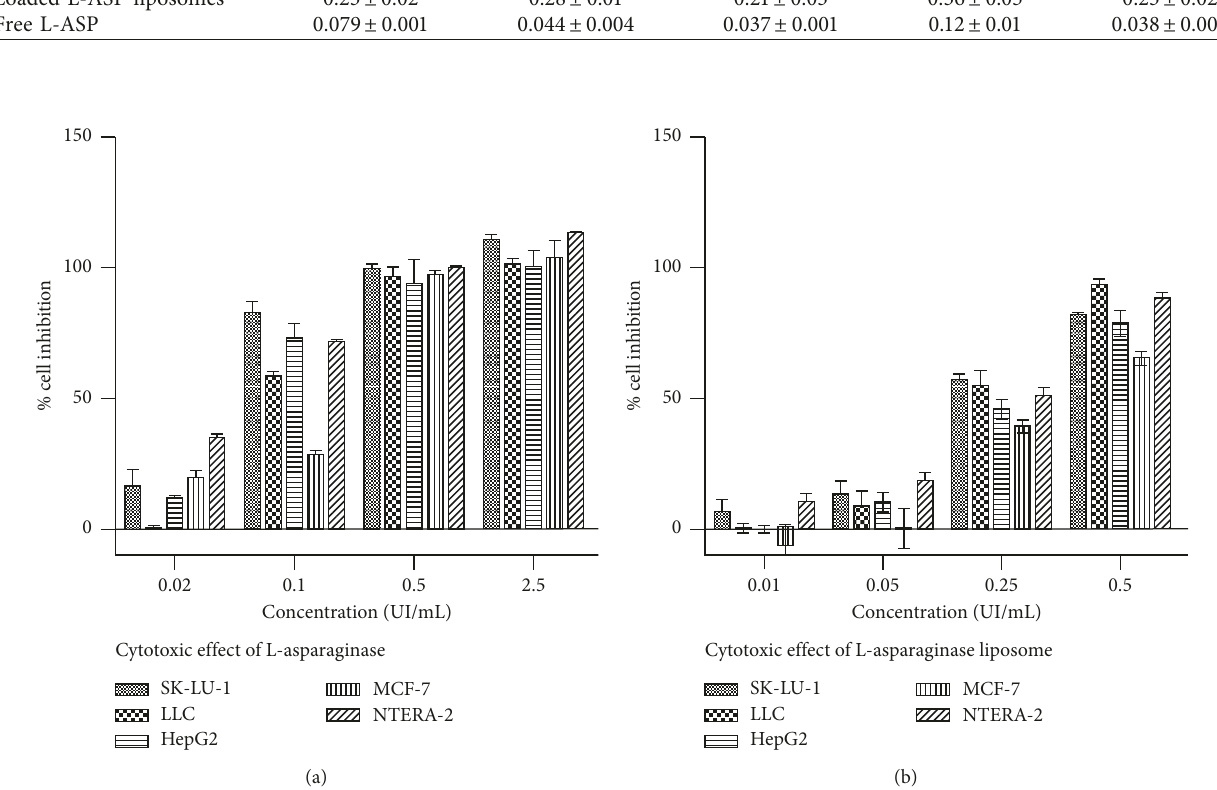
Figure 3: Effectiveness of free L-ASP (a) and L-ASP-encapsulated liposomes (b) on different cell lines. Cultured cells (1 treated with different concentrations of either liposomal (a) or free L-ASP (b). Normal saline was served as the negative control. Each value represents the mean ±